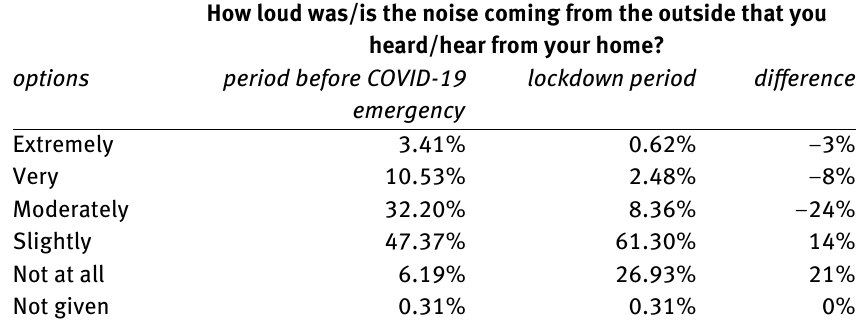
Table 10: Comparison between the lockdown period and the period before COVID-19 emergency regarding the perceived outside noise